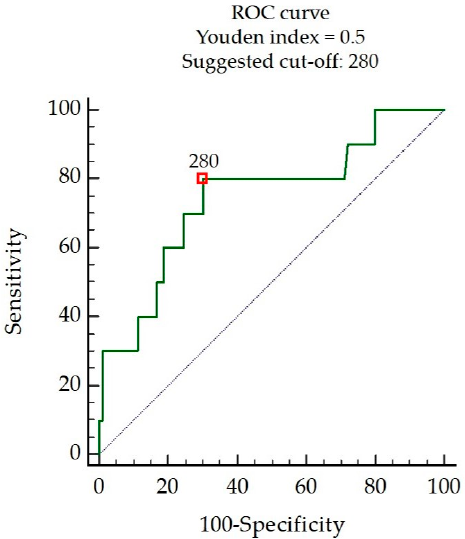
Figure 2. Receiver operating characteristic curve (ROC) suggesting the optimal sleep time in the supine position as a cut-off point in minutes for indicating its suitability to recognize SB episodes.